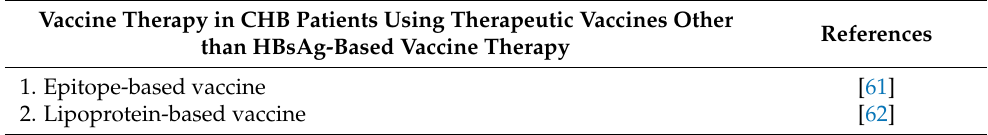
Table 4. Vaccine therapy for CHB patients with therapeutic vaccines other than HBsAg-based preventive